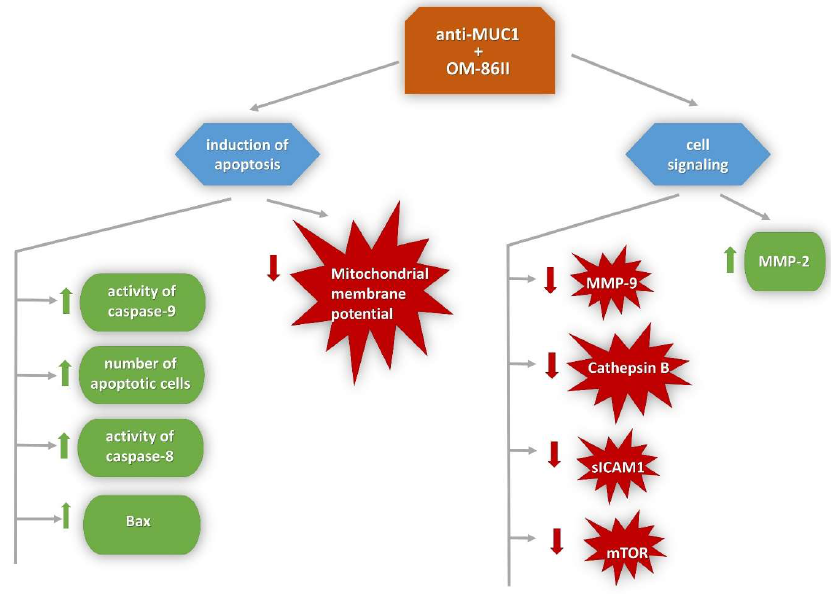
Figure 16. Mechanism of anticancer action of the anti-MUC1 antibody used with the novel diisoquinoline derivative in human gastric cancer cells.